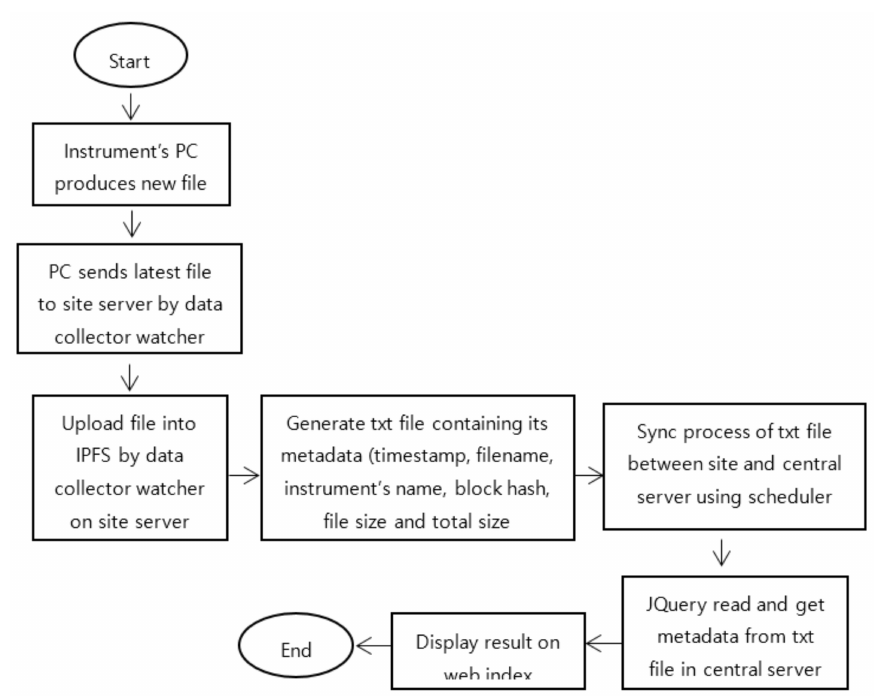
Figure 8. Flowchart of data monitoring by a passive